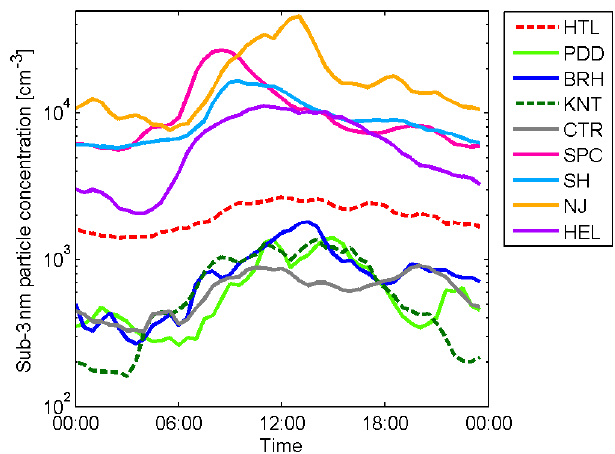
Figure 4. The median diurnal variation in sub-3nm particle con- centration at different measurement